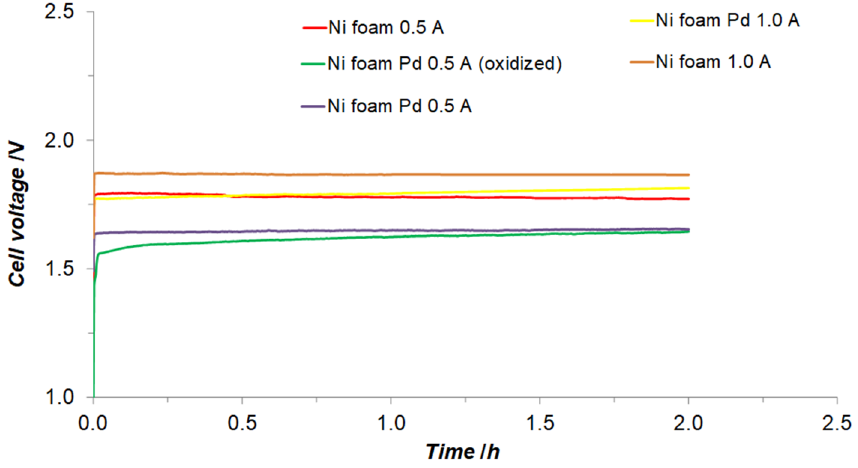
Figure 5. Single cell’s voltage as a function of electrolysis time. The process was carried out at 45 °C in 8 M KOH solution for current intensities of 0.5 and 1.0 A (anode: Ni foam/electro-oxidised Ni foam; cathode: Ni foam or Pd-modified Ni foam), and solution recirculation rate of 30 cm 3 min − 1 .